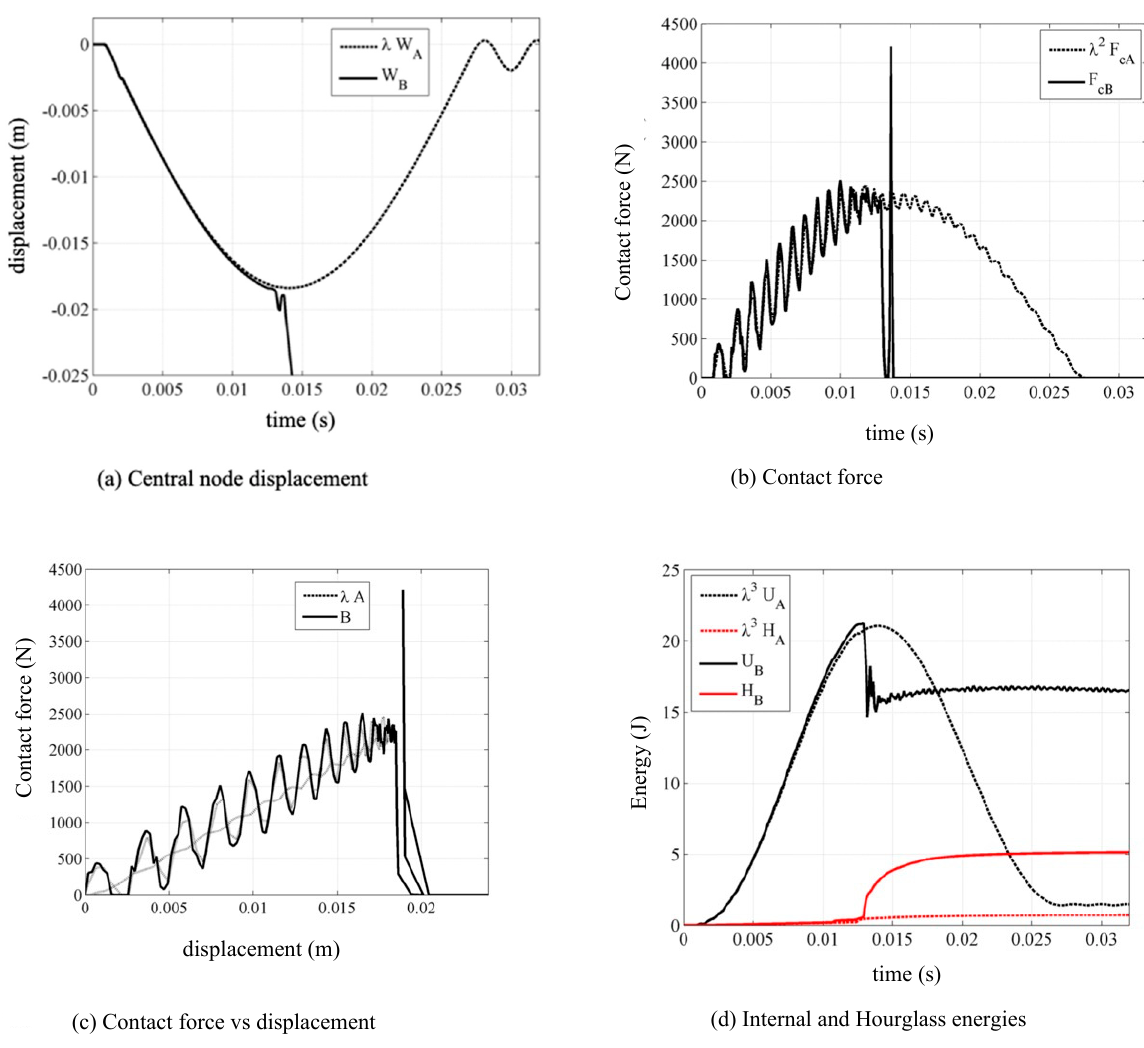
Figure 8. Comparison of the curves of case B with the scaled case “A”.